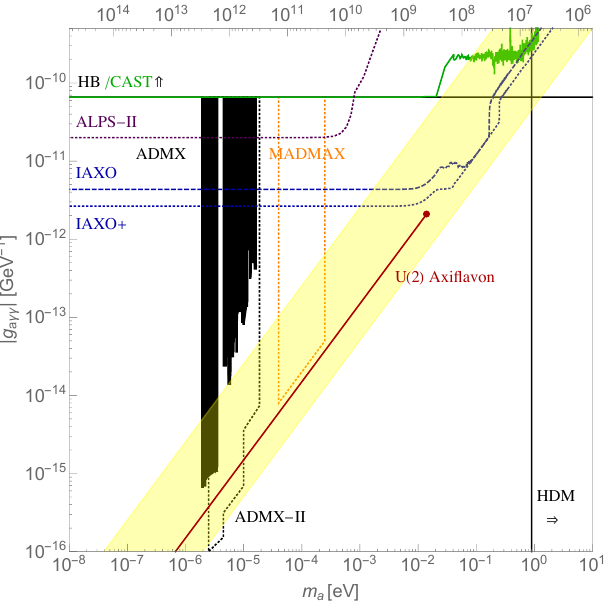
Figure 1 . Prediction of the axion-photon coupling as a function of the axion mass m a . The yellow band denotes the usual axion band of KSVZ models with a single pair of vector-like fermions, taken from ref. [44]. The red line denotes the parameter space of the U(2) Axi(cid:13)avon model, which extend up to the (cid:15) mark, denoting the bound from WD cooling, see table 13. Also shown are the bounds from structure formation excluding hot DM (HDM) [45{47], the bound from the evolution of Horizontal Branch (HB) stars in globular clusters [48], the expected sensitivity of the ALPS-II experiment [49], the present and future bounds from Axion helioscopes provided by CAST [50] and IAXO [51, 52], and from Axion Haloscopes like ADMX [53, 54], MADMAX [55] and the planned ADMX upgrade